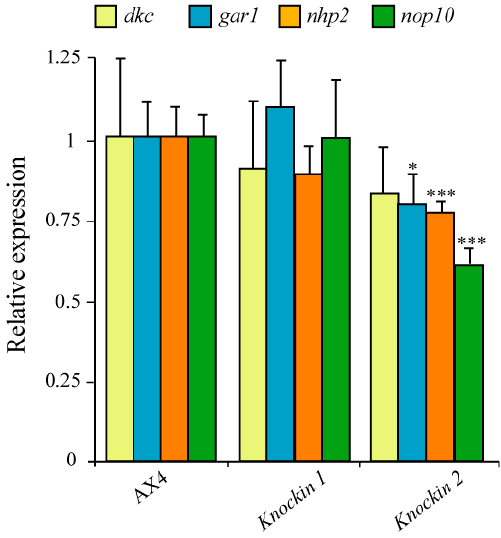
Figure 6. Expression of mRNAs coding for snoRNP component in D. discoideum dyskerin mutants. RNA was isolated from Wild-type (AX4) and dyskerin mutant (knockin 1, knockin 2) strains. The expression of the mRNAs coding for the snoRNP components dyskerin ( dkc ), GAR1 ( gar1 ), NHP2 ( nhp2 ) and NOP10 ( nop10 ) was determined by RT-qPCR. Expression data were normalized using the large mitochondrial rRNA as control. Expression values were related to those of the AX4 strain for each gene. Mean values and standard deviations from three independent experiments are represented. * p < 0.05; *** p < 0.001. Cells 2019 , 8 , x